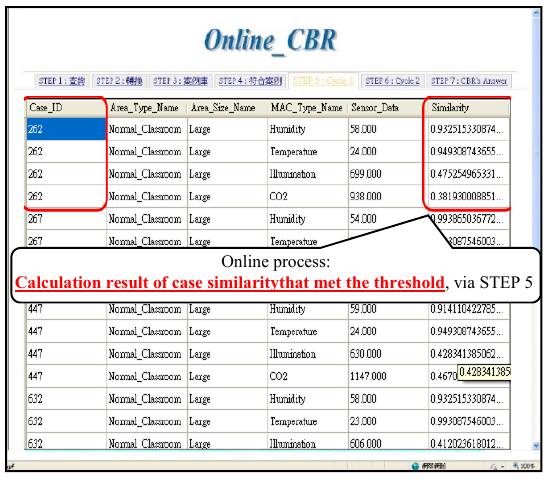
Figure 17. Calculation result of case similarity.